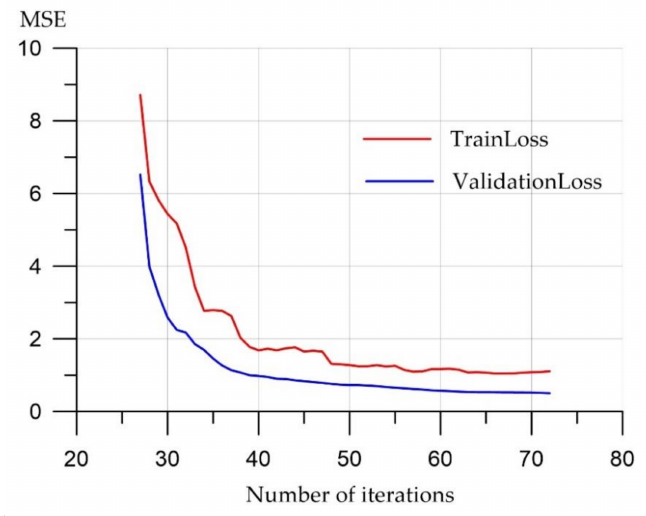
Figure 2. Neural network